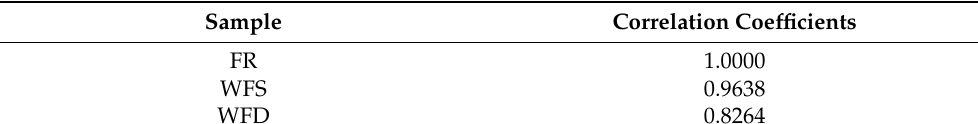
Table 3. Correlation coefficients of WFD and WFS compared with that of the reference wood between 1800 and 897 cm − 1 .